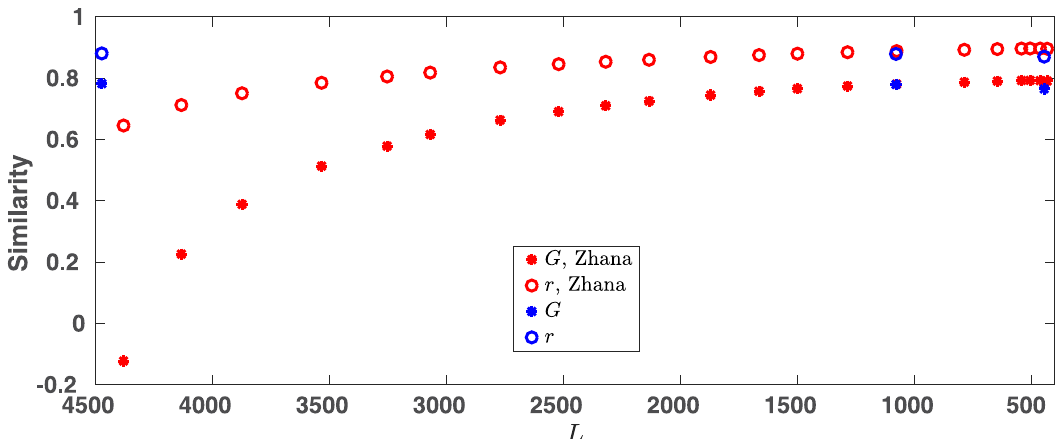
Fig 5. Comparing the two methods. The average correlation r , and goodness of fit G are plotted as functions of number of links using both our method (in blue) and Zhana’s (in red). Note that SUBN2 and ZN1075 have almost the same number of links (1078 and 1075 respectively) and give almost identical results, and so the blue symbols are on top of the red